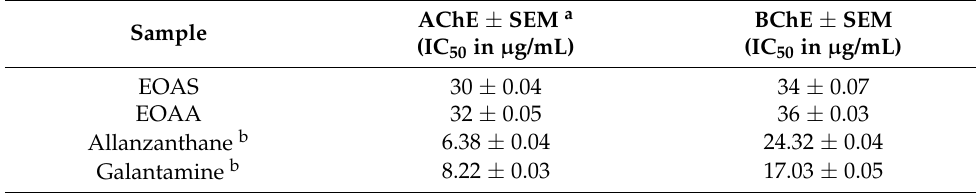
Table 4. Cholinesterase inhibition data of EOAS and